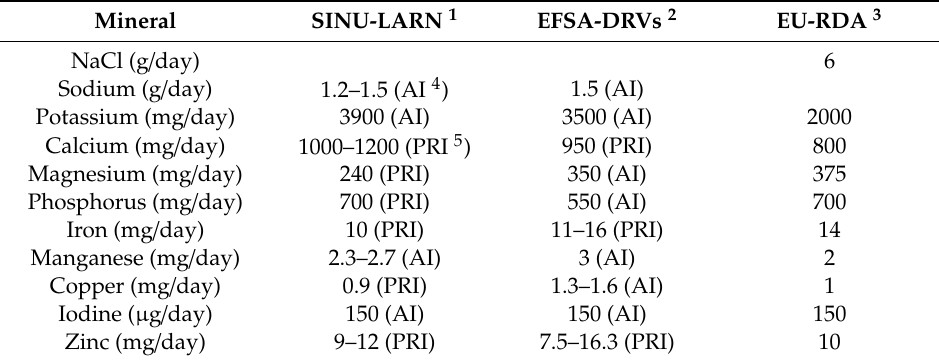
Table 1. Intakes and allowances recommended by SINU [5], EFSA [6] and EU [7].